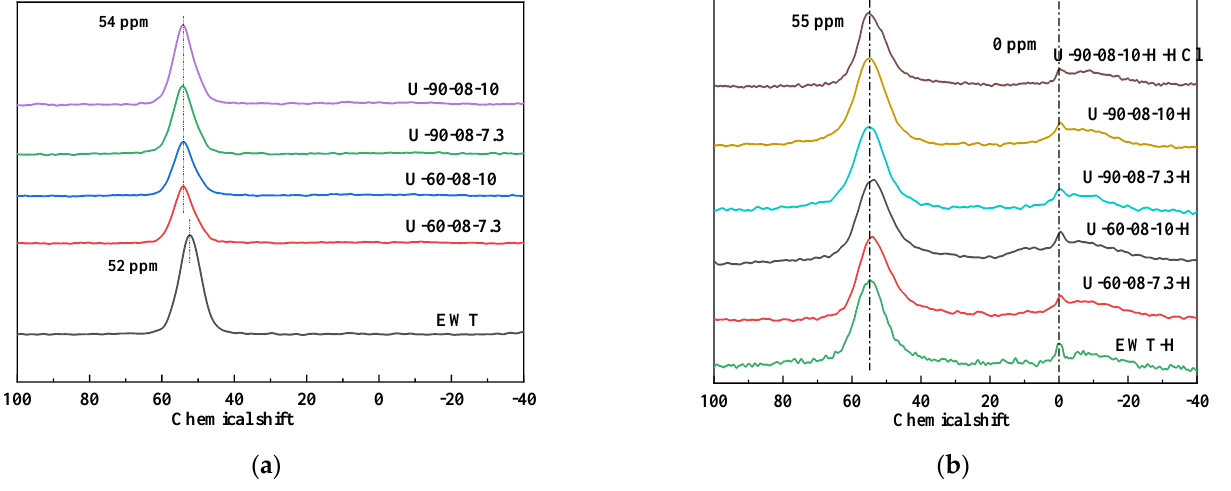
Figure 11. The 27 Al MAS NMR spectra of ( a ) as made and ( b ) calcined samples. 11 B MAS NMR spectra were used to investigate the boron coordination. As